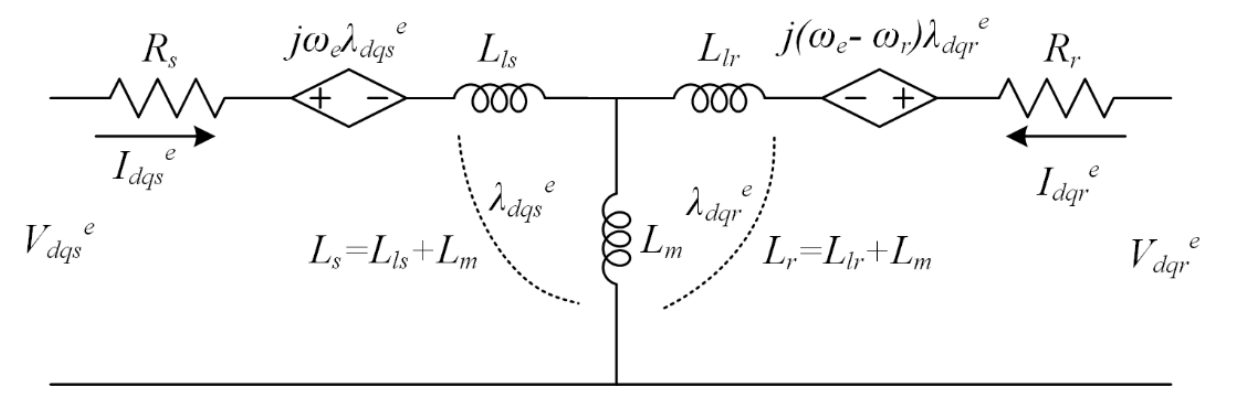
Figure 2. Equivalent model of a DIFWM.